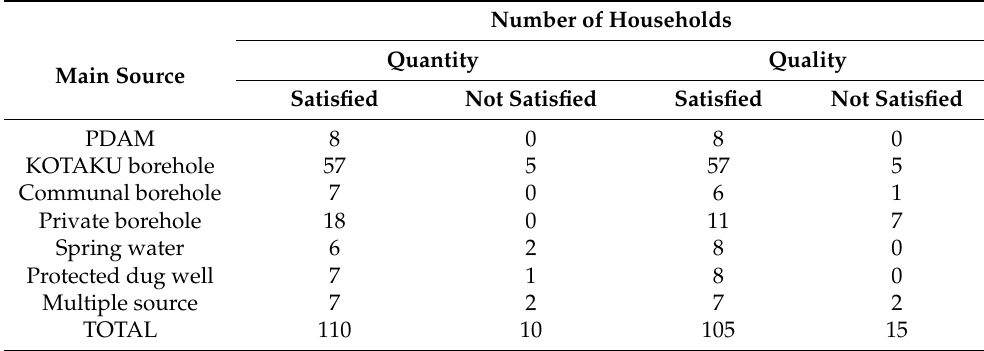
Table 3. Consumer satisfaction with water quantity and quality.